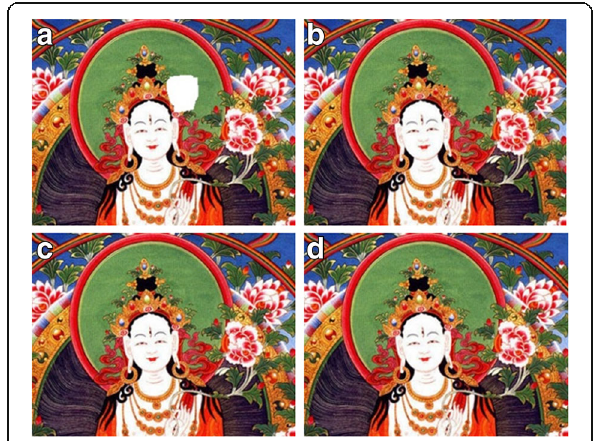
Fig. 10 Head crown damage of Tara and inpainting results by three algorithms. a Damaged image. b Repaired result by exemplar-based image inpainting. c Repaired result by ESEII. d Repaired result by